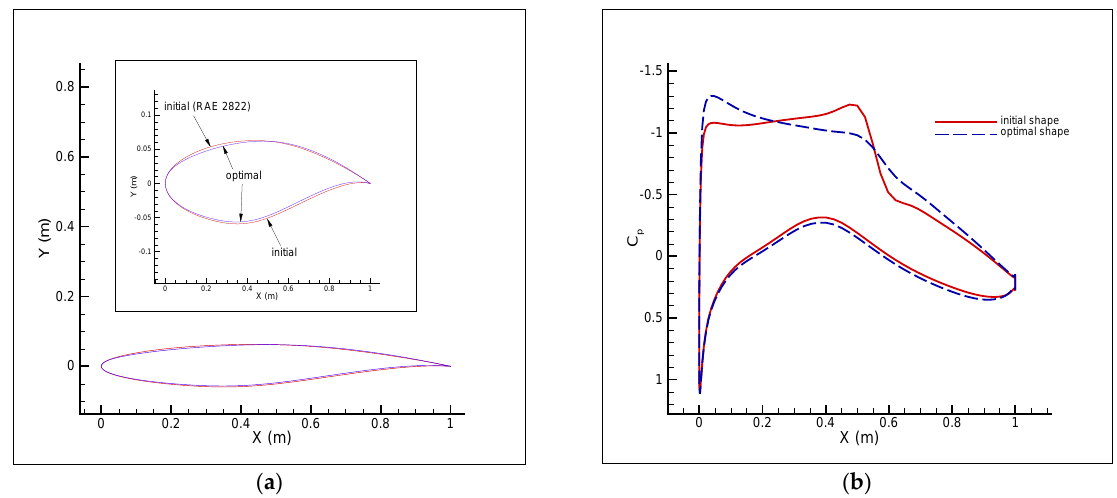
Figure 12. Comparison of initial and optimal airfoils used in the transonic turbulent flow shape optimization ( a ) and the corresponding airfoil surface pressure coefficients ( b ) for Test case I.